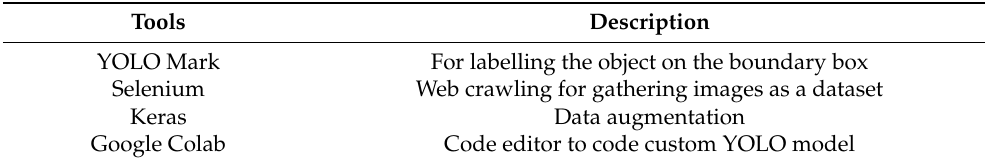
Table 2. Development Environment Tools.